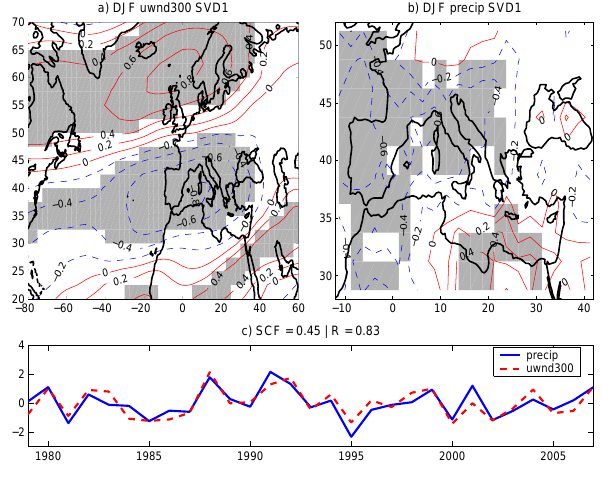
Fig. 8. Same as Fig. 6, but for